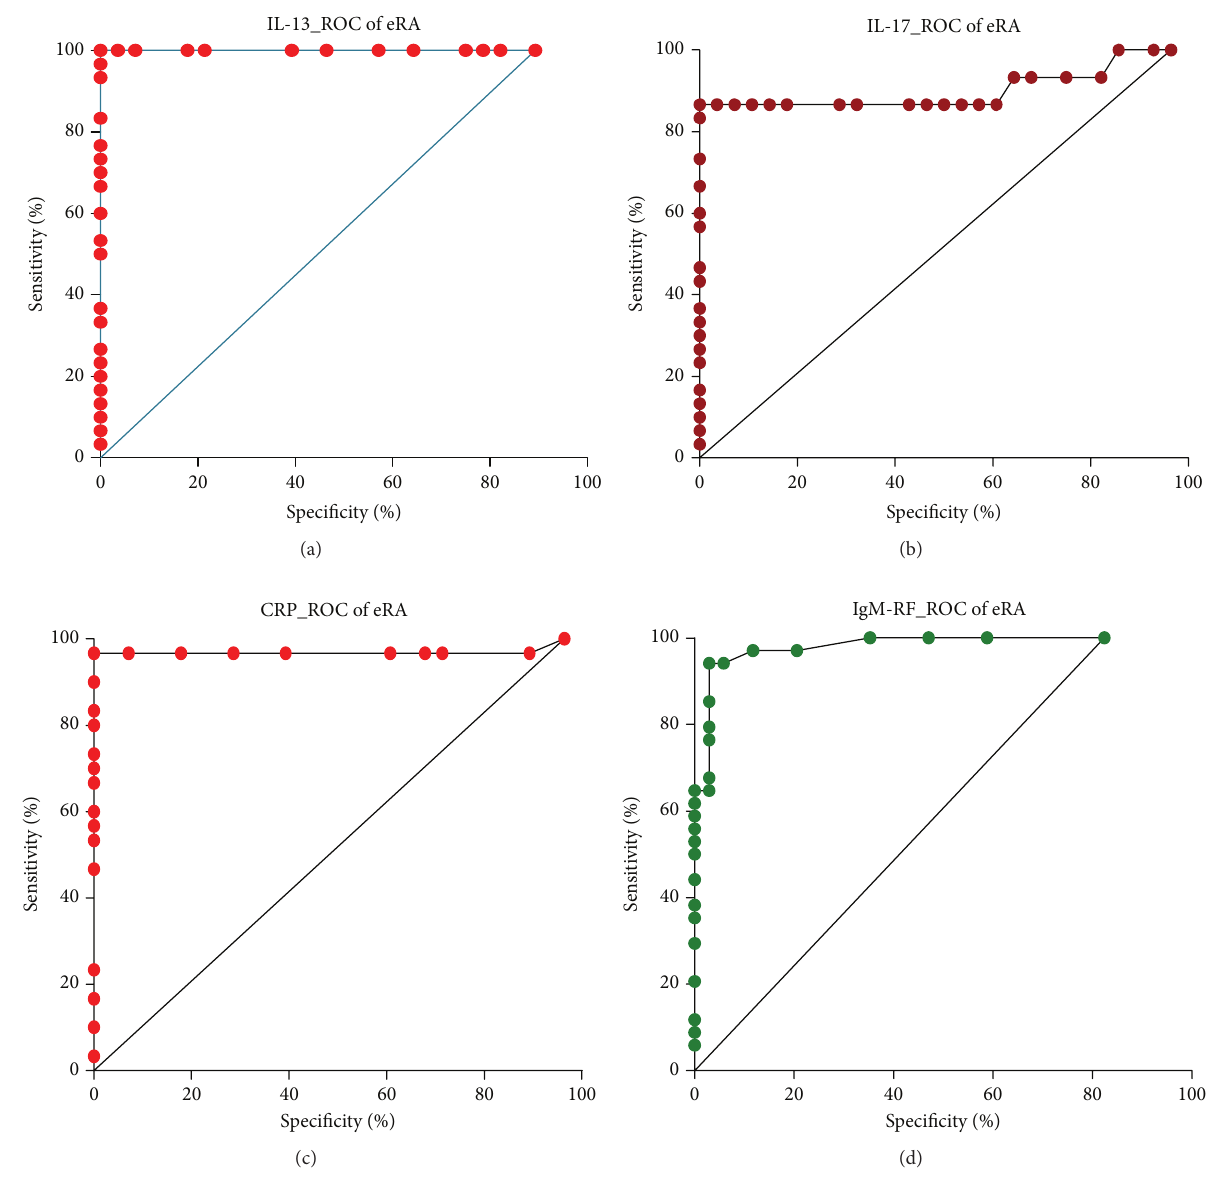
Figure 3: Comparison of ROC curves for IL-13 (a), IL-17 (b), CRP (c), and IgM-RF (d).